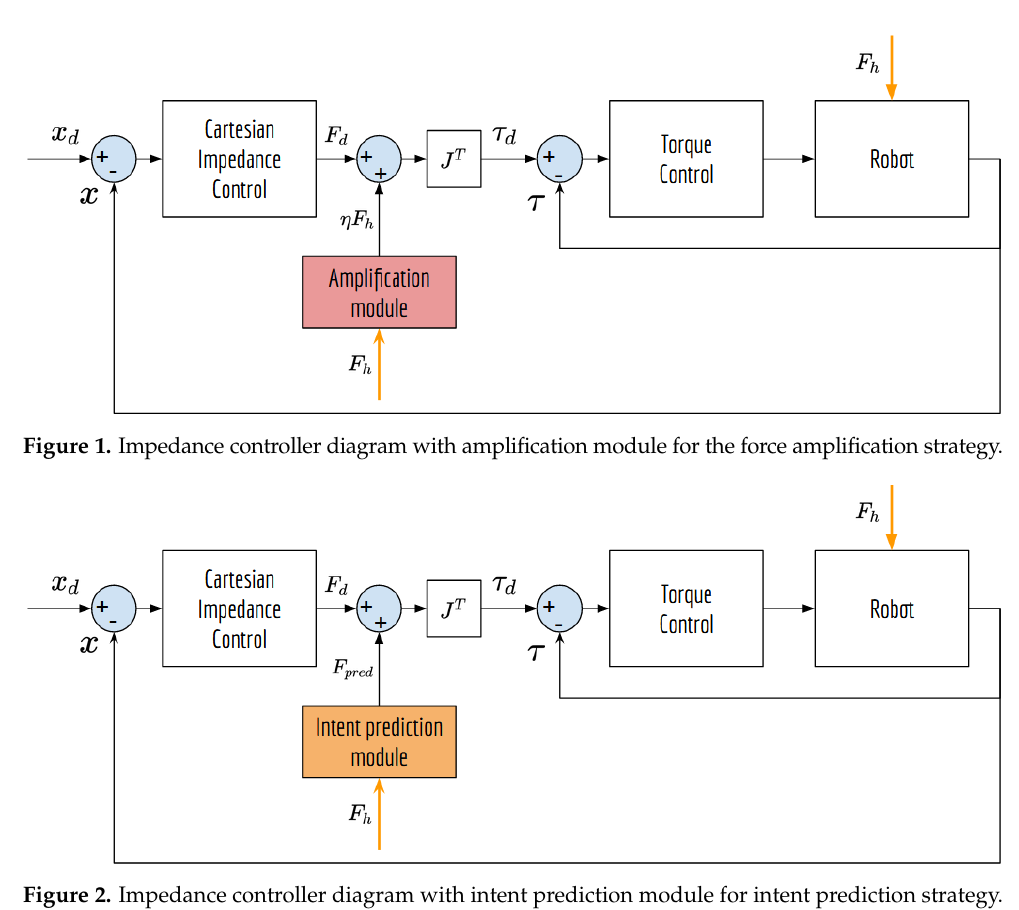
Figure 2. Impedance controller diagram with intent prediction module for intent prediction